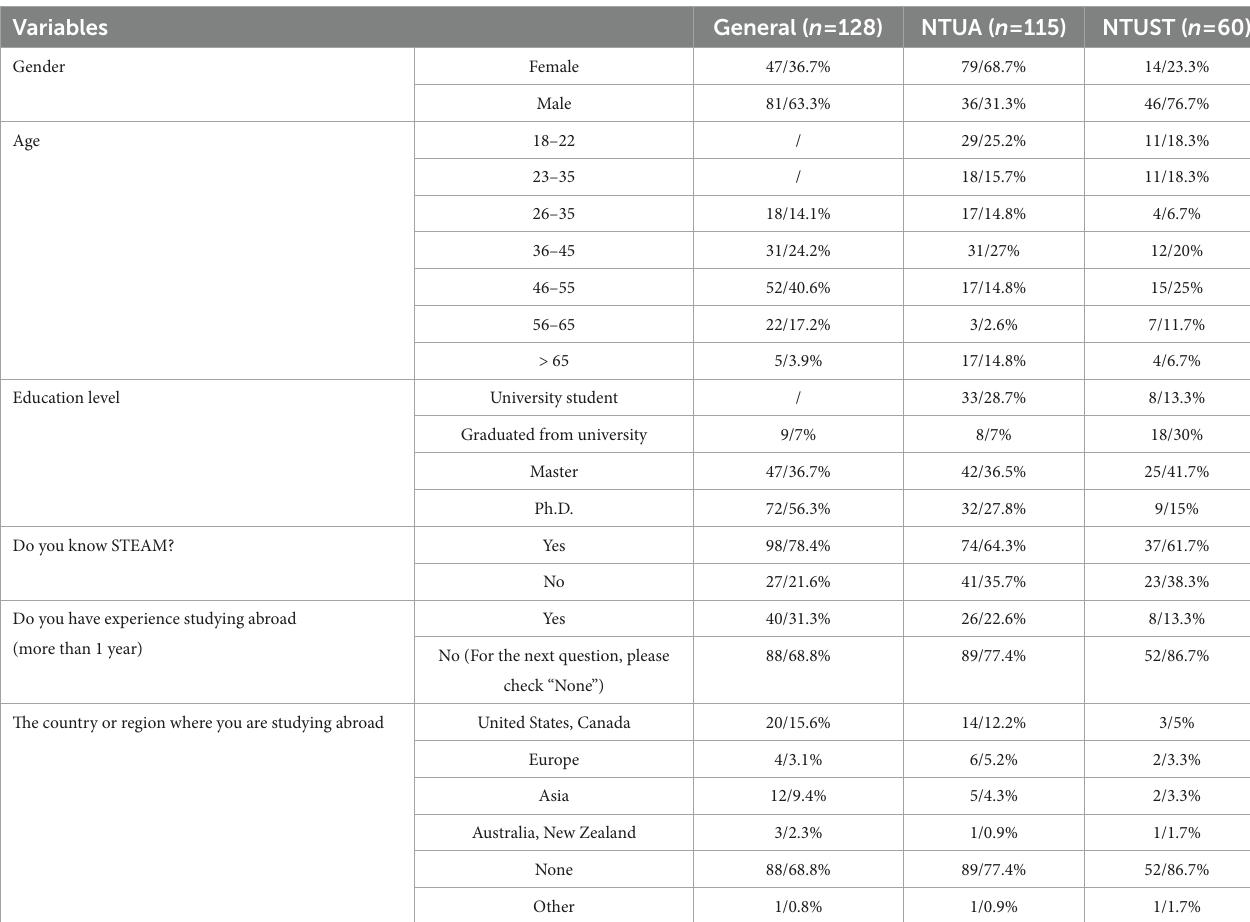
TABLE 3 Basic data of the subject.